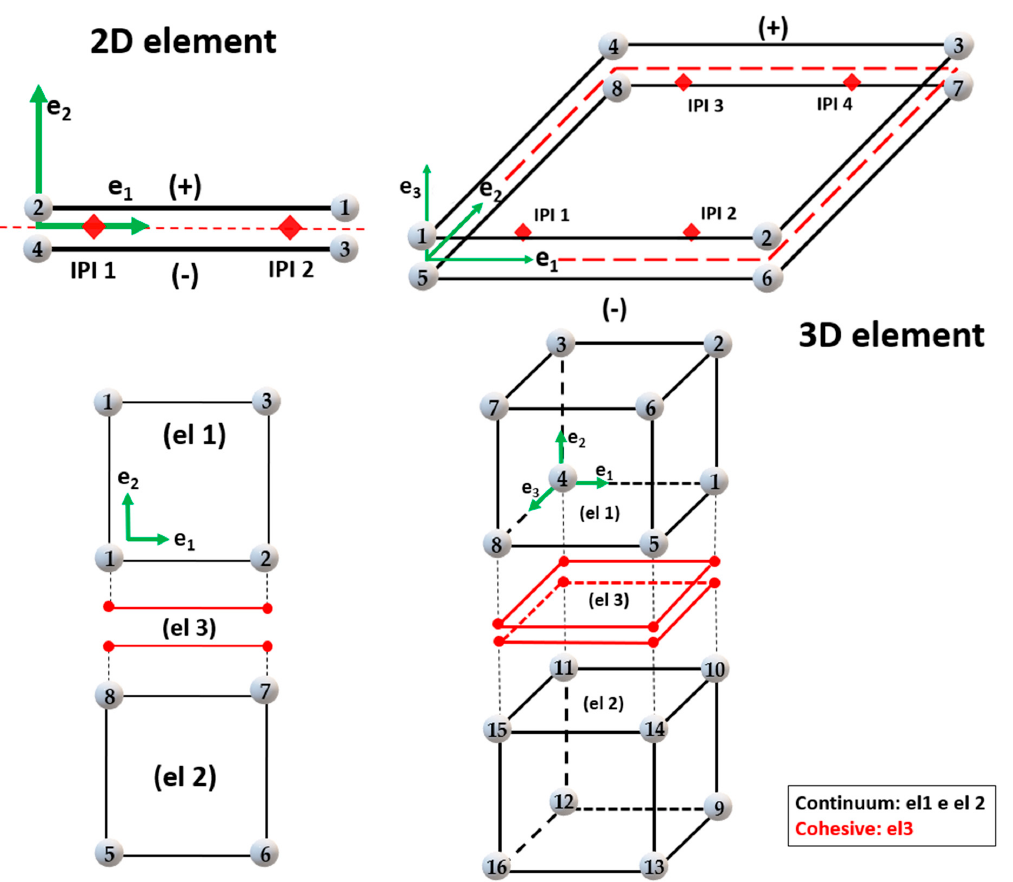
Figure 35. Cohesive element nodes and integration point positions, and connecting cohesive and continuum elements.